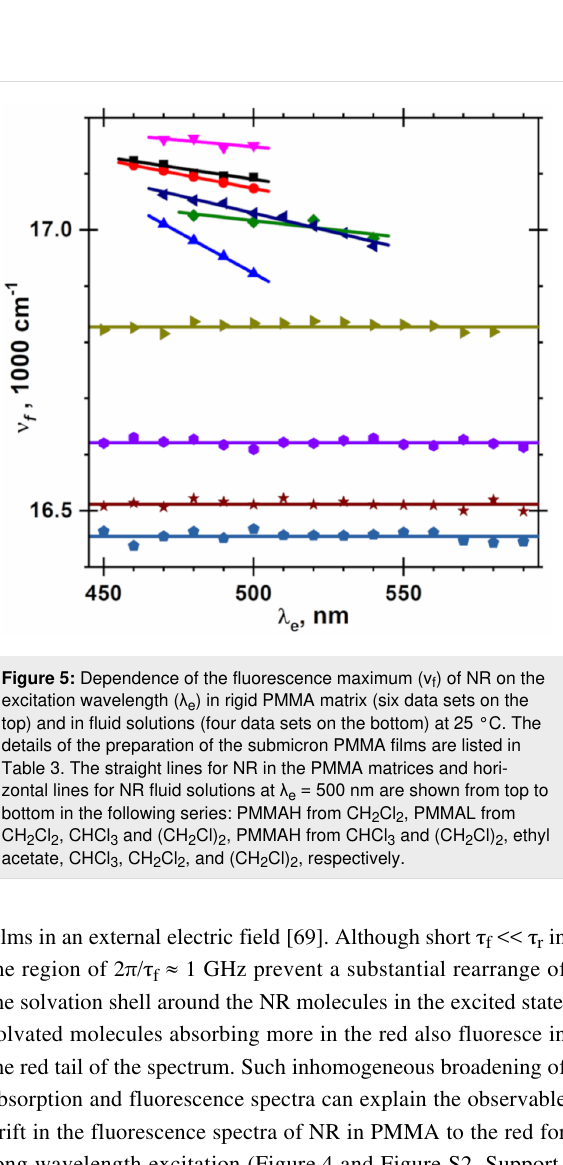
Table 3: Fluorescence maxima ( ν f ) of NR at the excitation wavelength ( λ e ) of 500 nm in PMMA spin-coated film of thickness ( d ), ν f drift rate ( d ν f / d λ e ) , Lippert solvent polarity function and dielectric constant ( ε ) of the PMMA films at 25 °C .